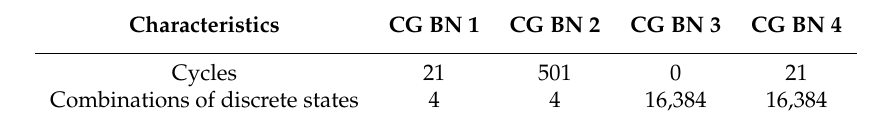
Figure 3. Additional Conditional Gaussian BNs. Table 2. Characteristics of four CG BNs with n =